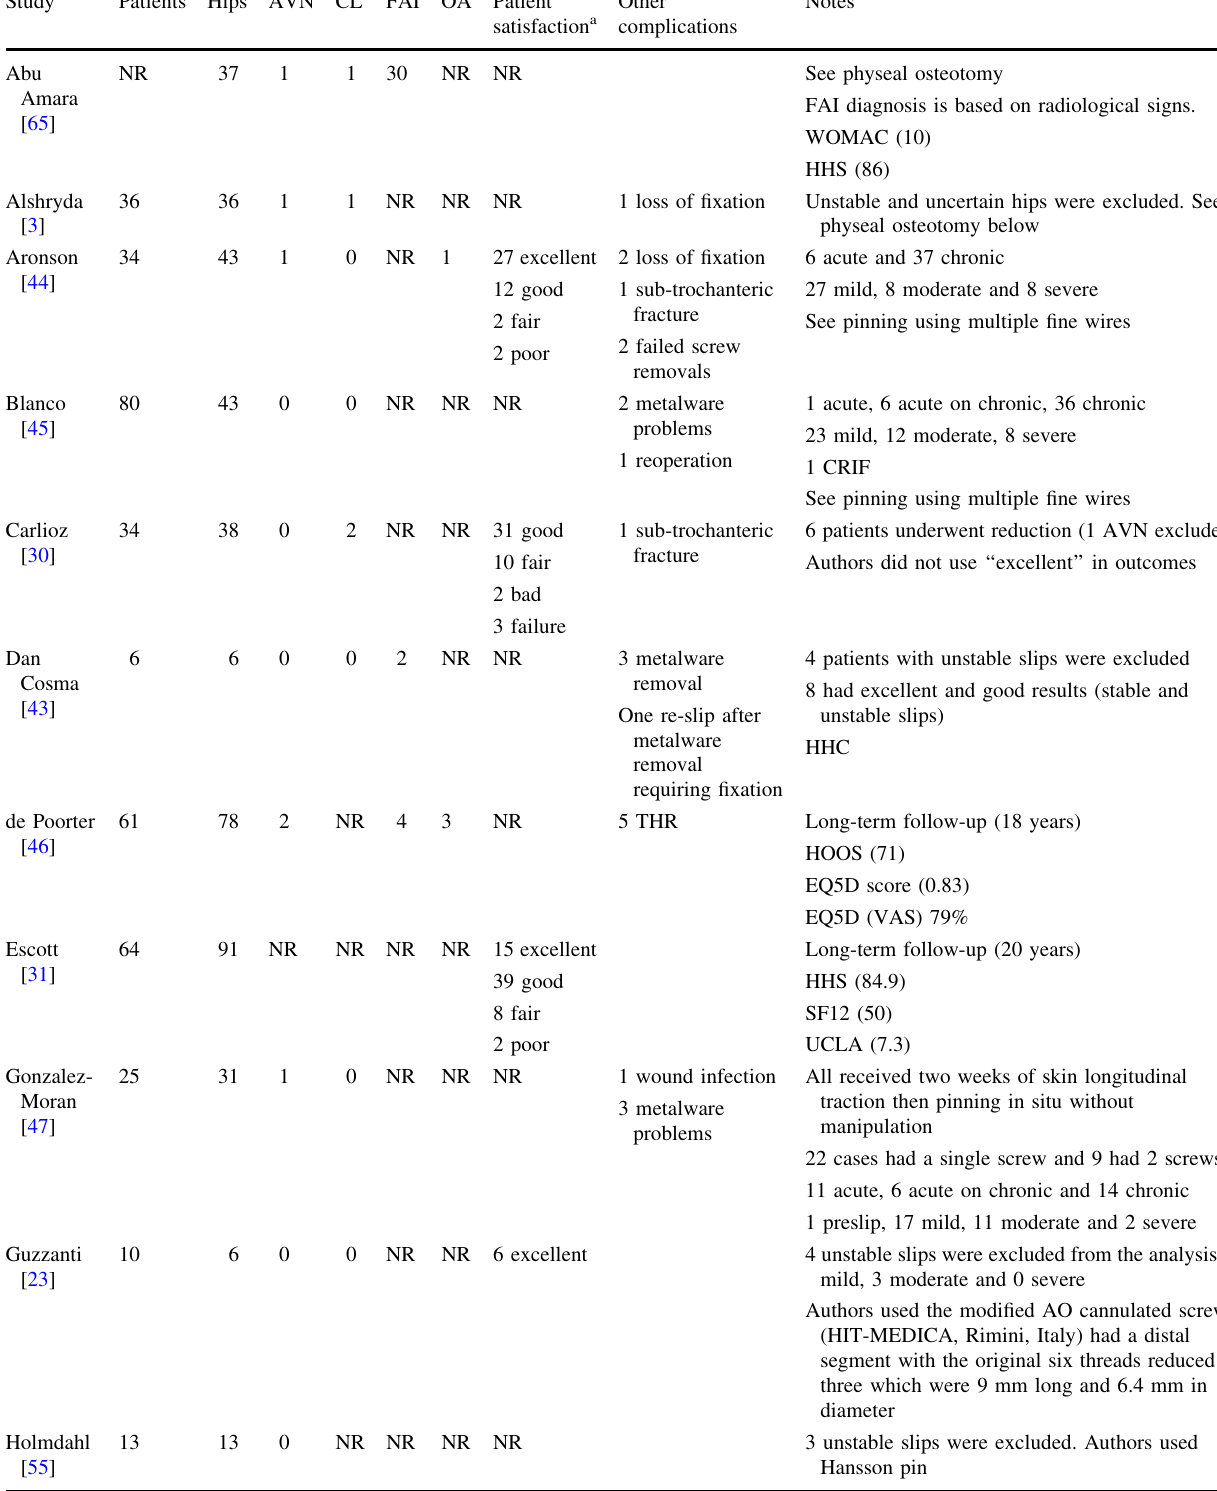
Table 6 Studies of pinning in situ using screws